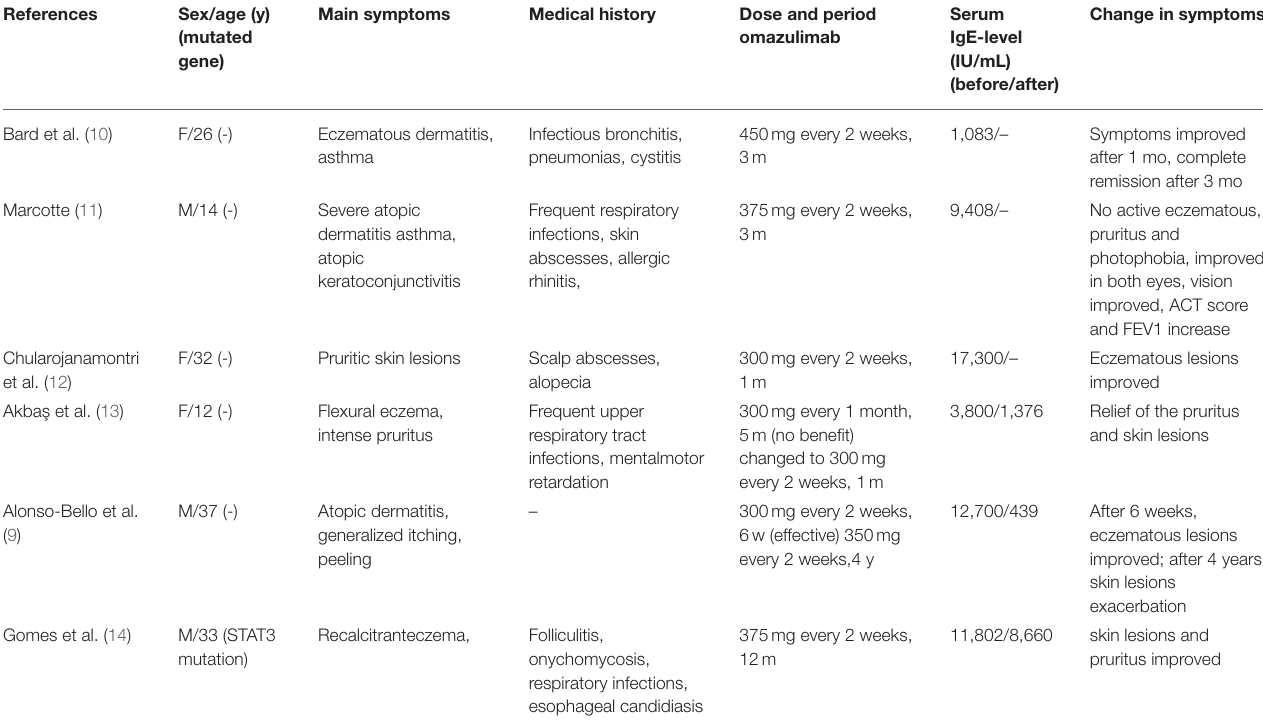
TABLE 1 | Six articles related to omalizumab for